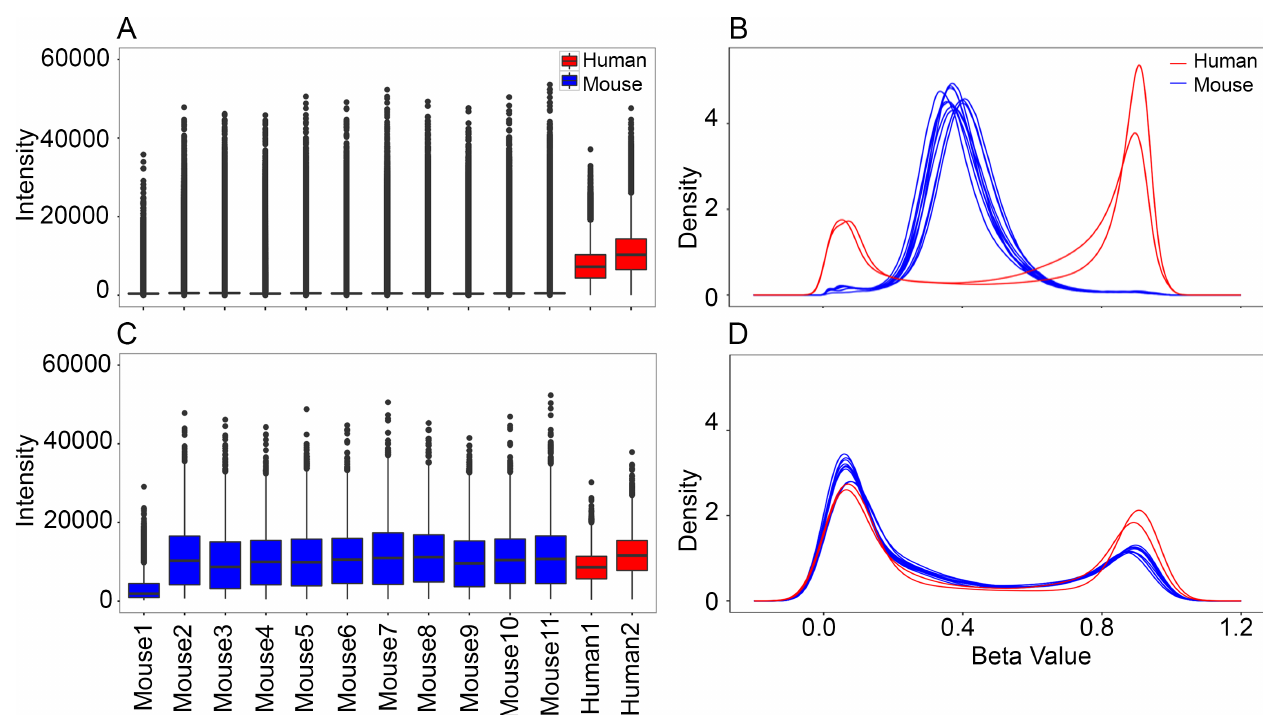
Fig 2. Distribution of signal intensities and methylation β -values in mice and humans. For the full set of 866,836 probes on the Illumina Infinium MethylationEPIC, the mouse samples have (A) low signal intensity compared to the two human samples, and (B) the β -values have a unimodal distribution that peaks at ~0.4. The two human samples have the expected bimodal distribution for β -values. For the conserved set of 13665 probes, both the (C) signal intensity, and the (D) β -value distribution in the mouse samples are comparable to the two human reference samples. The signal intensity for mouse1 is relatively low for the conserved set of probes and this sample plots as an outlier in the principal component analysis.